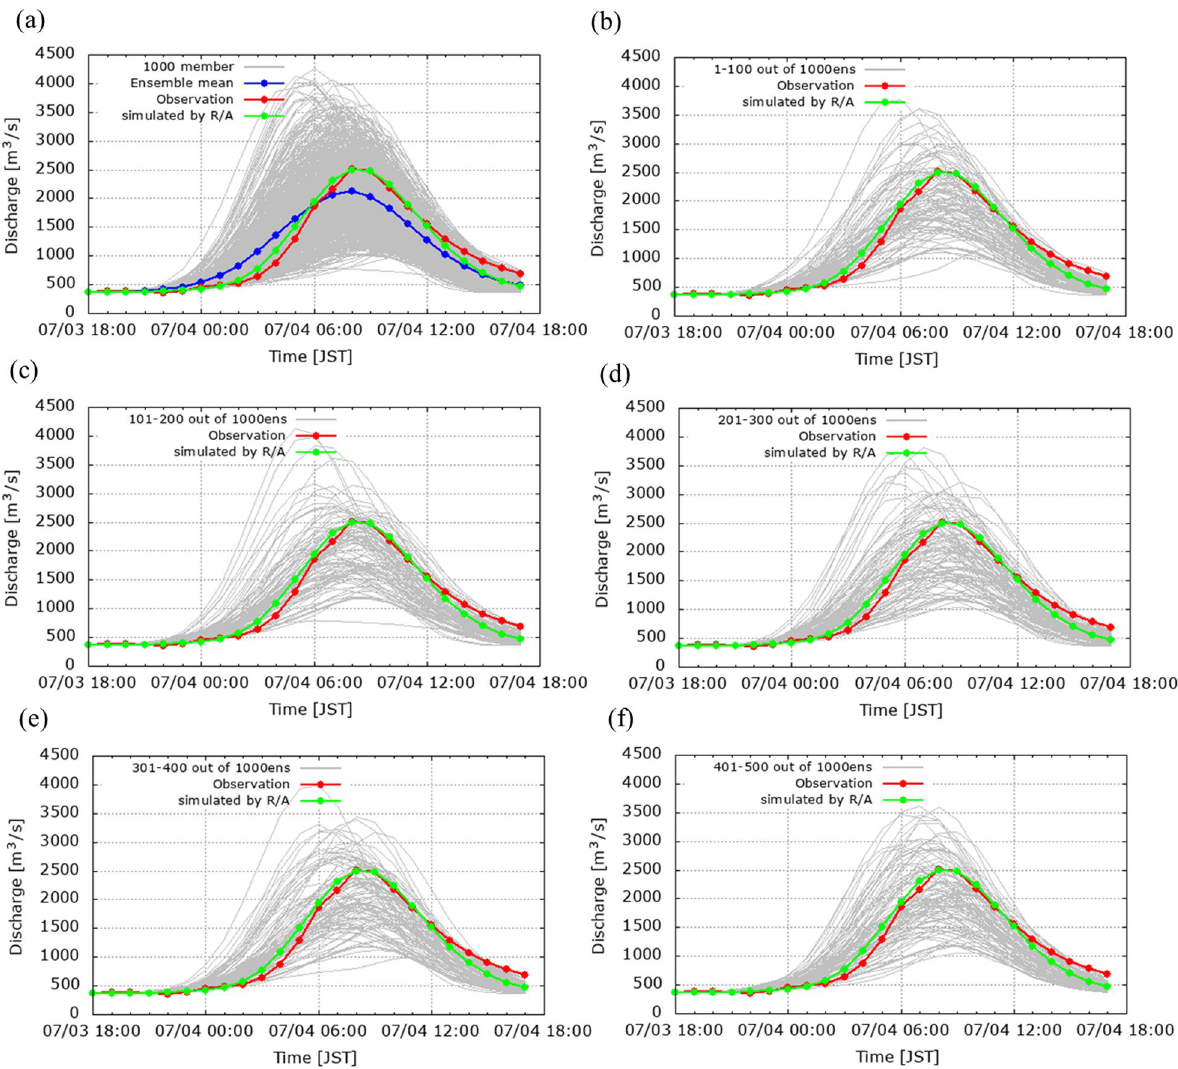
Fig. 14 Observed and simulated discharge to Kawabegawa dam catchment by 1000 (LETKF) a Hourly discharge of 1000 member, b of m1-100,